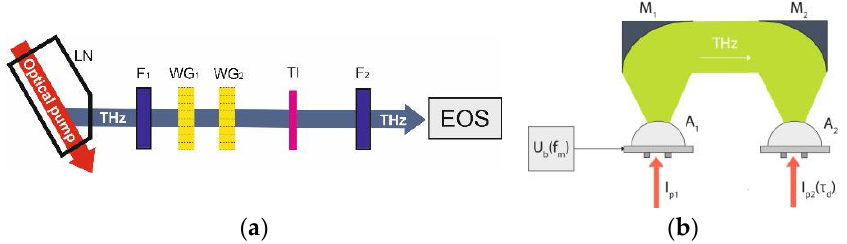
Figure 3. Sketches of experimental setups for studying the generation of the third terahertz harmonic ( a ) and the generation of terahertz radiation in the antenna ( b ).